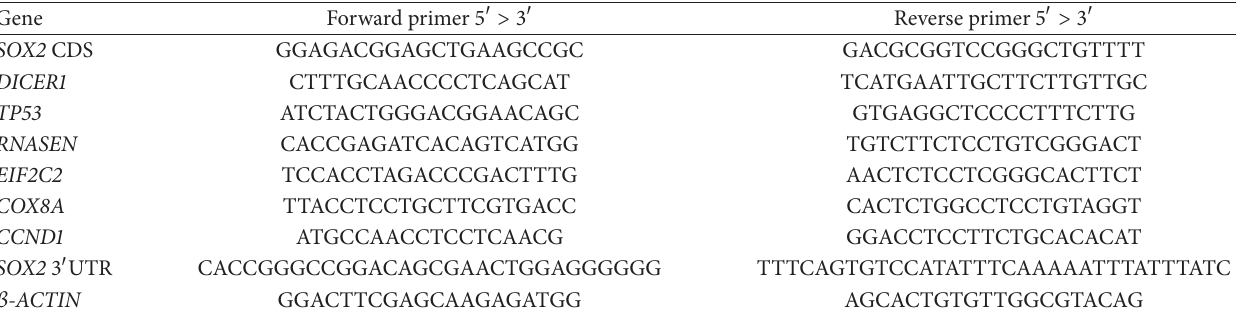
Table 5: RT-PCR primer